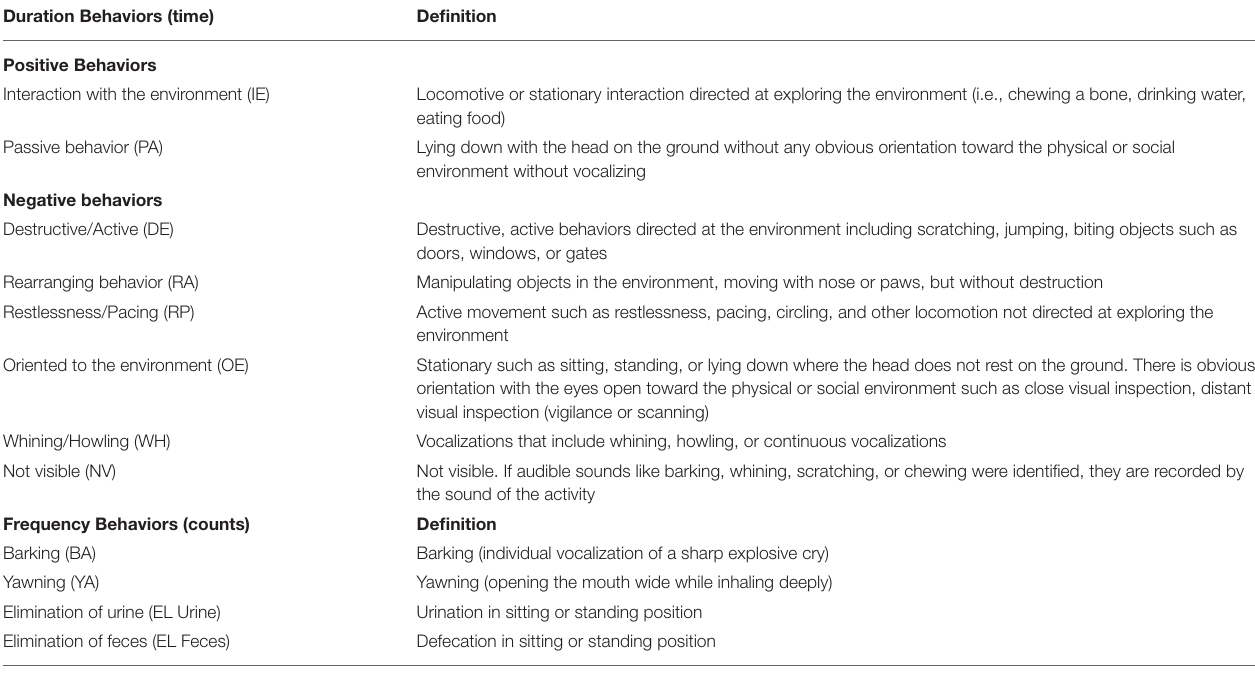
TABLE 1 | Description of the behaviors observed in the video recordings.